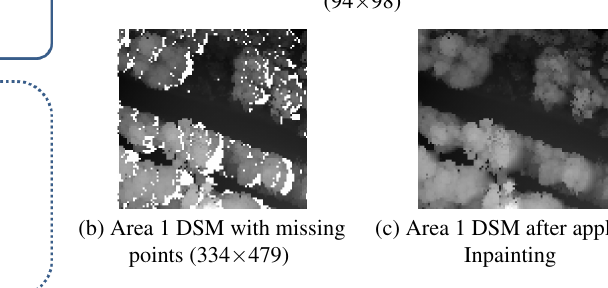
Figure 2. Registration error and inpainting algorithm for recovering missing LiDAR